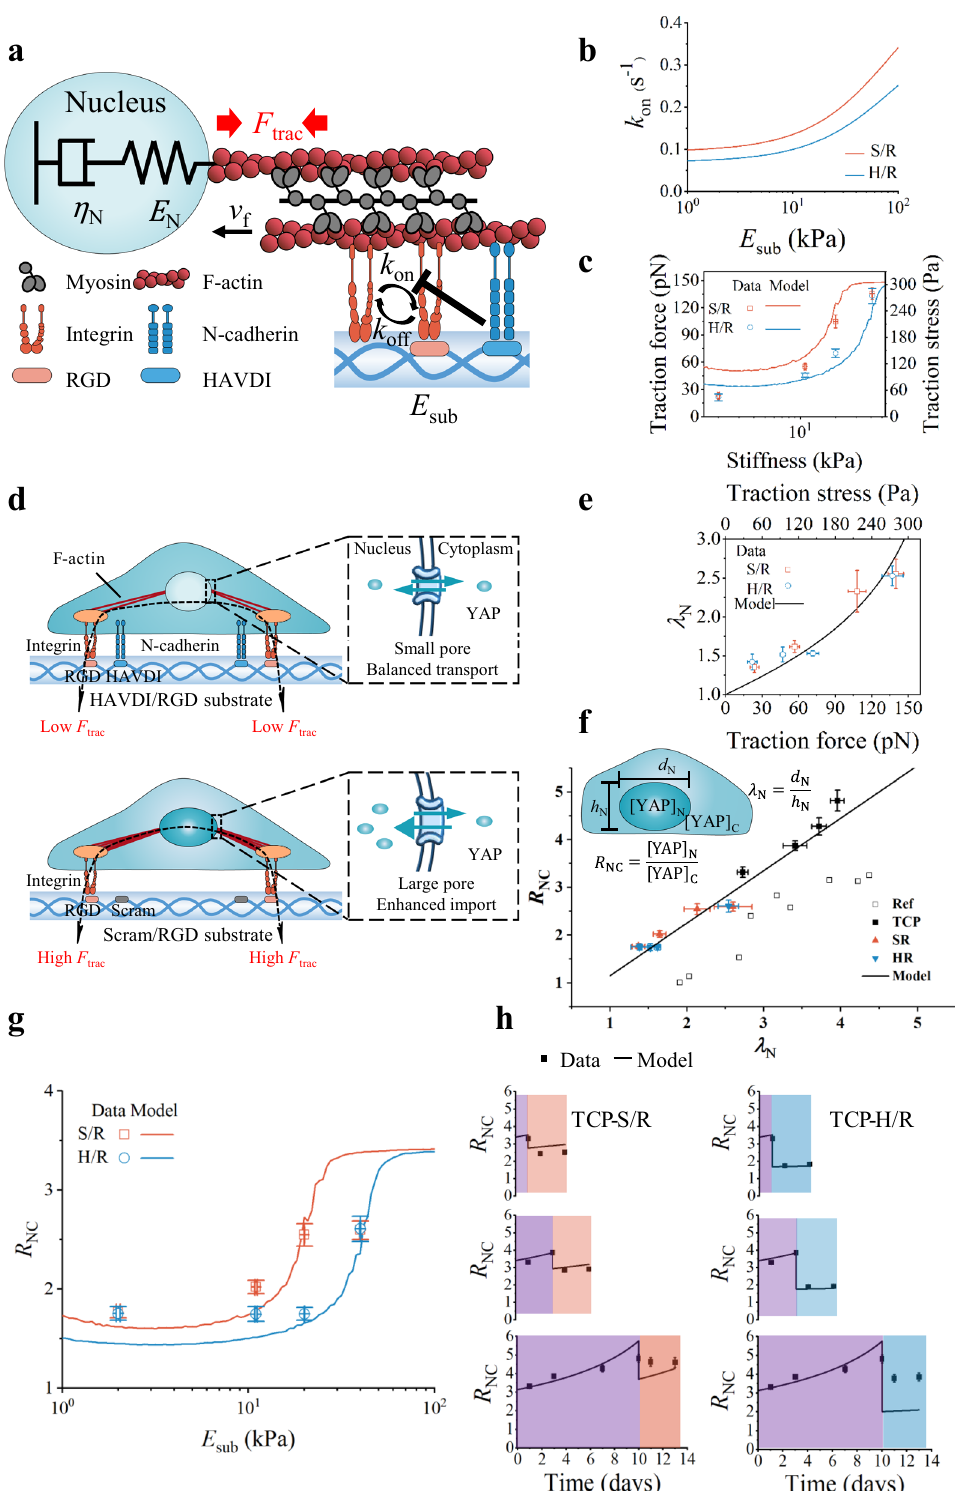
Phosphatase Color Development Kit (Beyotime, C3206) following the manu- facturer ’ s instructions. Cell nuclei were then stained with DAPI to count the total cell numbers. Percentages of ALP positive cells were calculated by counting the number of blue-violet stained cells and then dividing by the total cell number. YAP and RUNX2 n/c ratio quanti fi cation . For sparse cells, the nucleus and cytoplasm were identi fi ed by F-actin and DAPI staining, and the n/c ratio R sparse NC